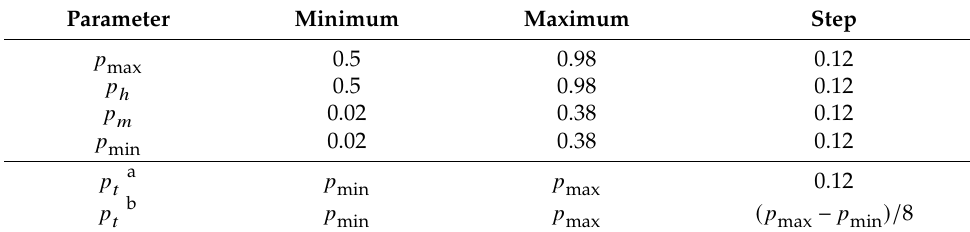
Table 2. Configuration of OctoMap